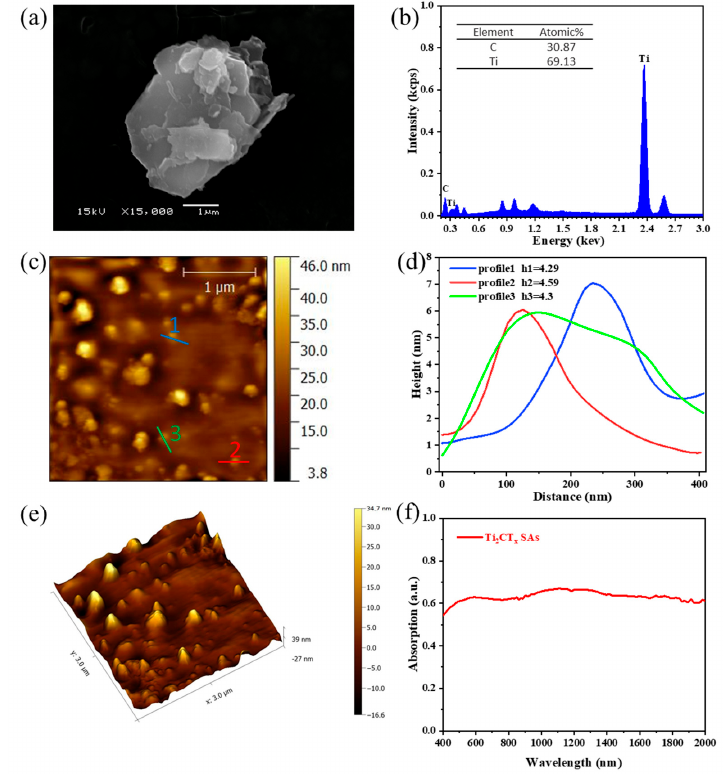
Figure 2. ( a ) SEM image of Ti 2 CT x . ( b ) EDS of Ti 2 CT x . Left inset: The table of detailed element content distribution. ( c ) AFM image of Ti 2 CT x . ( d ) The corresponding thickness of the synthesized Ti 2 CT x . ( e ) The 3D topographical image of the Ti 2 CT x . ( f ) UV-NIR absorption spectrum of Ti 2 CT x in IPA.